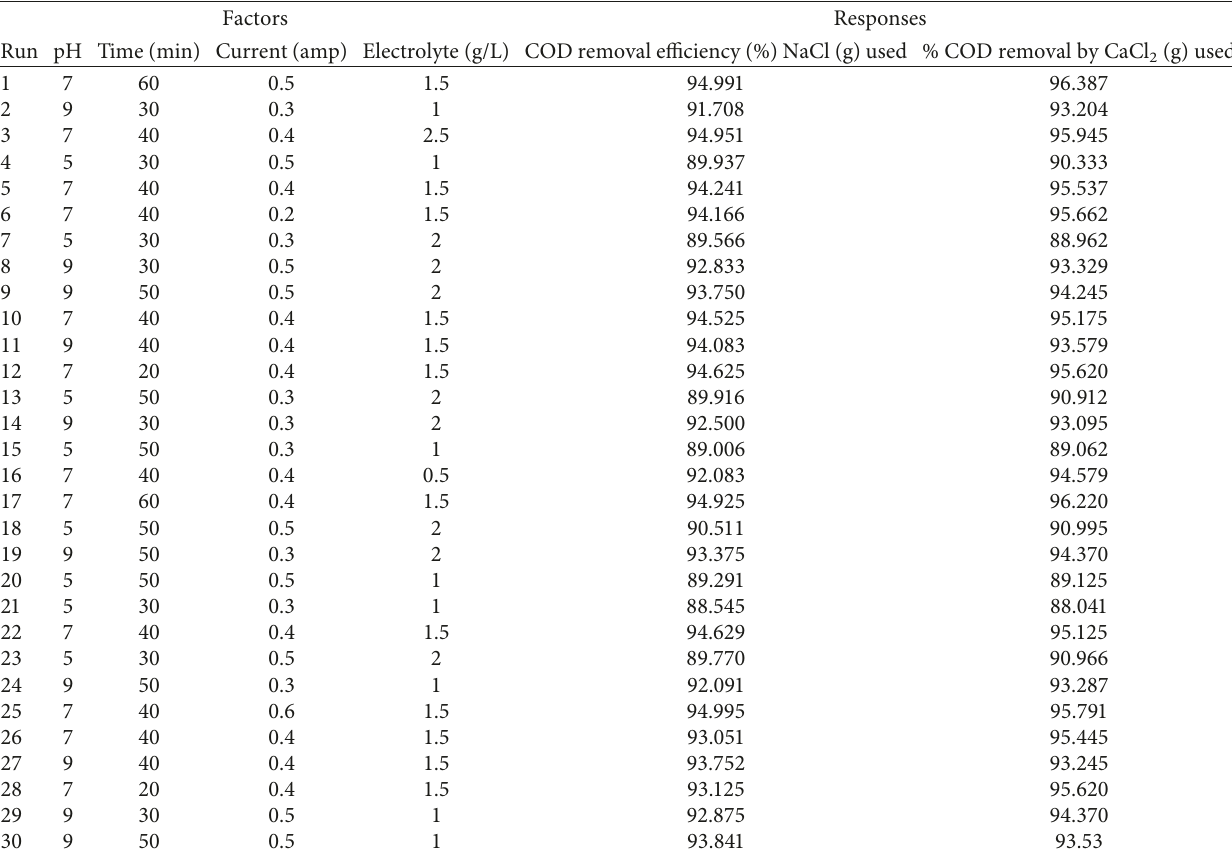
Table 1: CCD results for COD removal by ECO/NaCl and CaCl